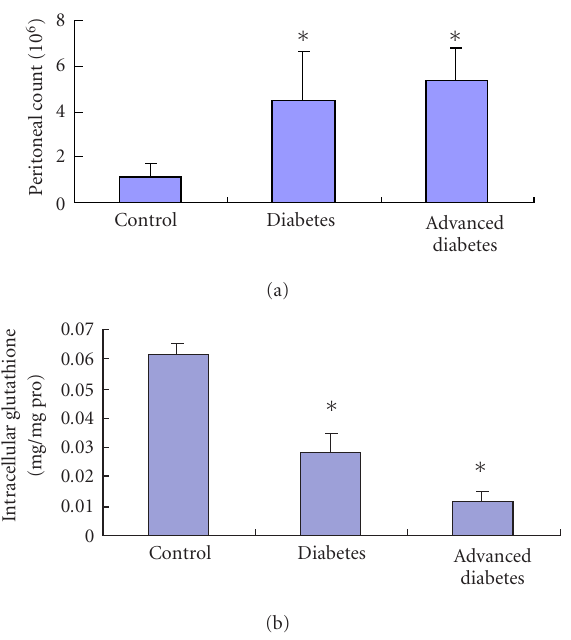
Figure 1. The periodic change of peritoneal Mp. (a) Mp count. There was significant di ff erence between the diabetic and control groups ( P < . 05), and the count increased significantly after the onset of diabetes ( P < . 01). (b) The amount of intracellular GSH in adherent Mp of the mice. Mp collected from the diabetic mice showed significantly decreased content compared to that of con- trol Mp. Results shown are representative of three experiments, and the Mp were all resting Mp.